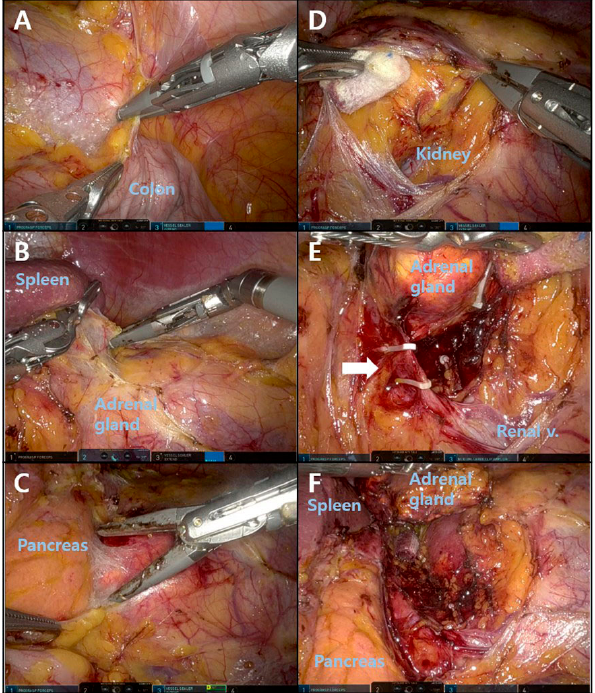
Figure 3. Procedure for robotic left adrenalectomy. ( A ) Left colon mobilization. ( B ) Spleen mobilization. ( C ) Pancreas and Gerota’s fascia dissection. ( D ) Exposure of the left kidney. ( E ) Adrenal vein identification and ligation. ( F ) Adrenalectomy completion.